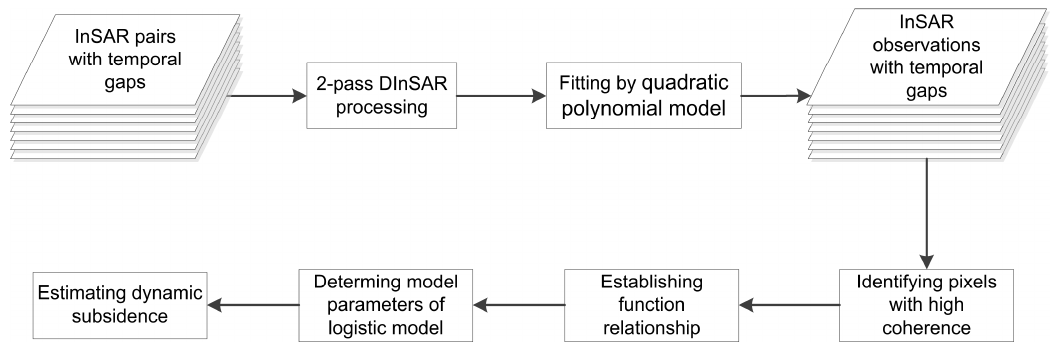
Figure 1. Block diagram of deriving dynamic subsidence of coal mining areas from InSAR observations with temporal gaps.